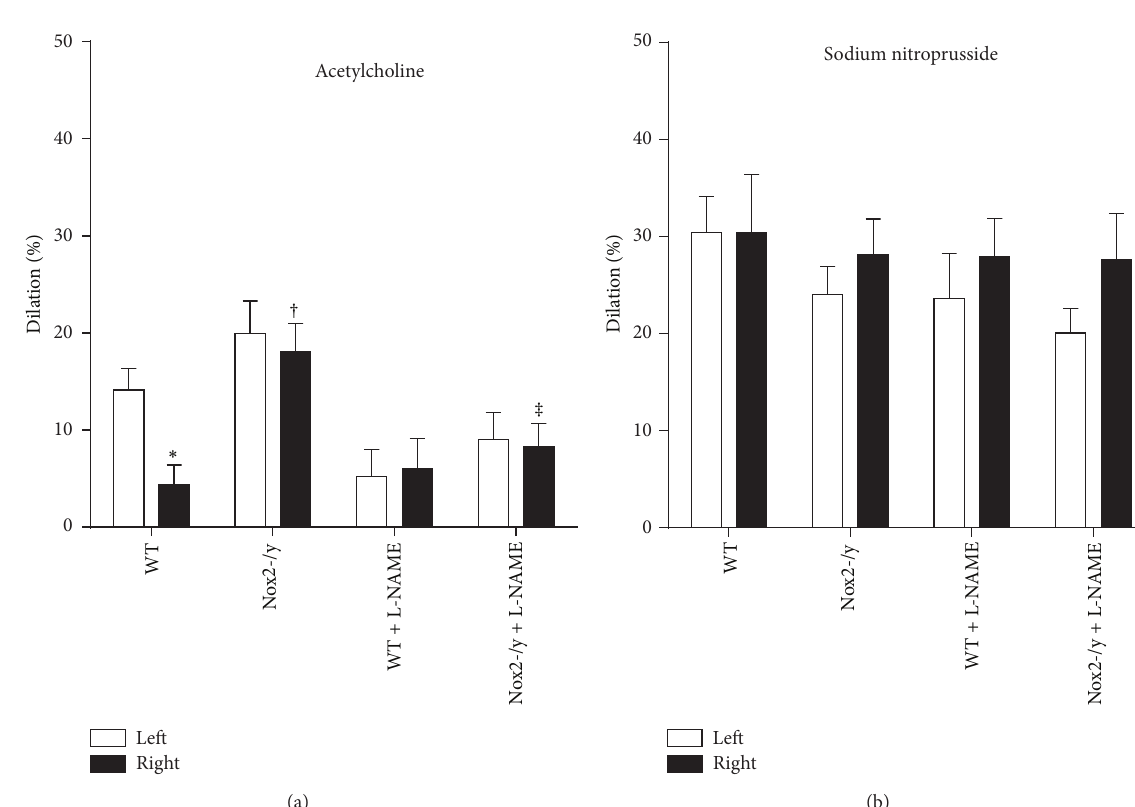
Figure 3: Graph showing endothelium-dependent and -independent vasodilation in cerebral arterioles. Acetylcholine (Ach, 10 −5 mol/L) (a) or sodium nitroprusside (SNP, 10 −7 mol/L) (b) was suffused in artificial CSF for 5 min in 8 mice. ∗ 𝑃 < 0.05 versus left-sided WT group; † 𝑃 < 0.05 versus right-sided WT group; and ‡ 𝑃 < 0.05 versus right-sided Nox2-/y